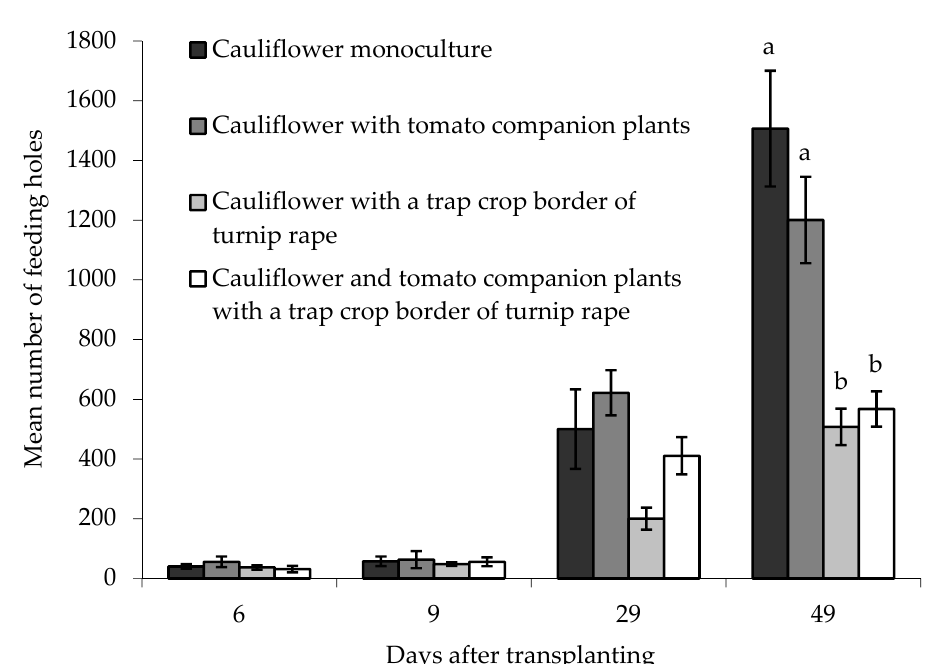
Figure 6. Number of flea beetle feeding holes (mean ± SE) on leaves of eight ‘inner’ cauliflower plants grown under different treatments at different days after transplanting. n = 3 for all means. Means with different letters (a–b) denote significant differences between treatments.